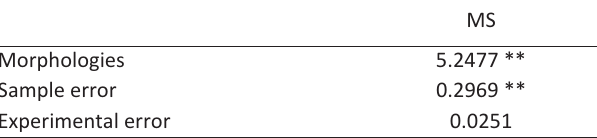
Table 3 ­ Mean Squares (MS) of the comparison of protein con­ centrations from the three Cereus morphologies (erect, tortuosus and monstruosus shoots) and their respective sampling and experimental mistakes